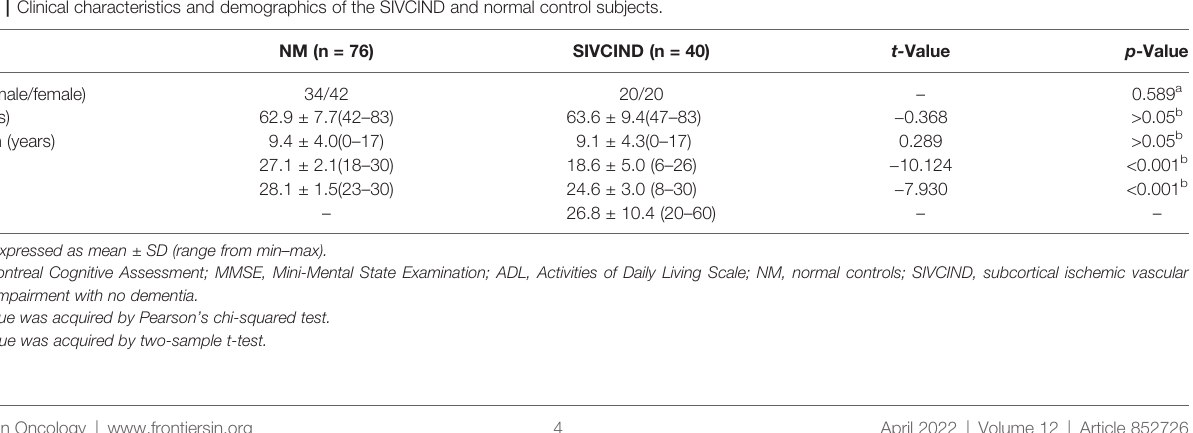
TABLE 1 | Clinical characteristics and demographics of the SIVCIND and normal control subjects. NM (n = 76) SIVCIND (n = 40) t- Value p -Value